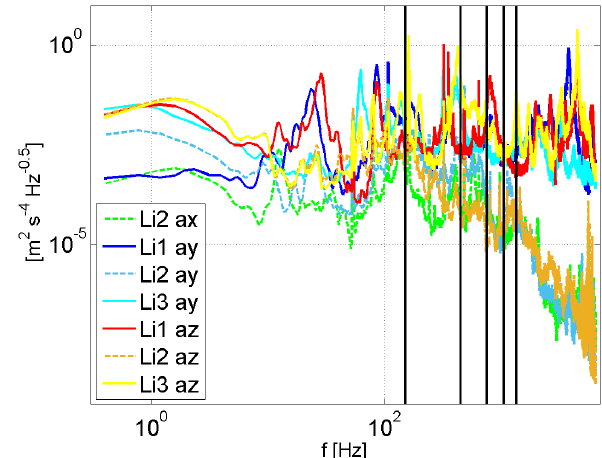
Figure 6. Time series of the accelerations in z direction of the three LI-COR sensors during a flight section of 3min duration on 23 Oc- tober 2013, illustrating the vibrations the LI-COR sensors were ex- posed to. The flight section took place above agricultural land at 220m altitude. The acceleration measurements of this flight section are representative for other flight sections at different, but constant altitude. The acceleration measurements at the Li1 are shown in green, at the Li2 in blue and at the Li3 in magenta. The data were obtained during the part of the flight indicated in yellow in Fig. 3.